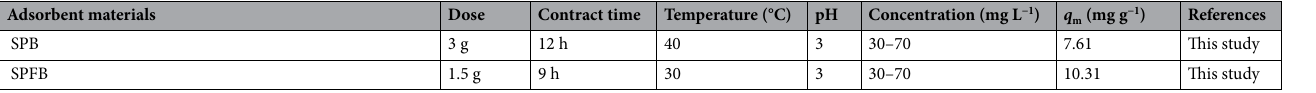
Table 6. Comparison of the maximum adsorption capacity for lead and RB4 dye adsorptions by various adsorbents.